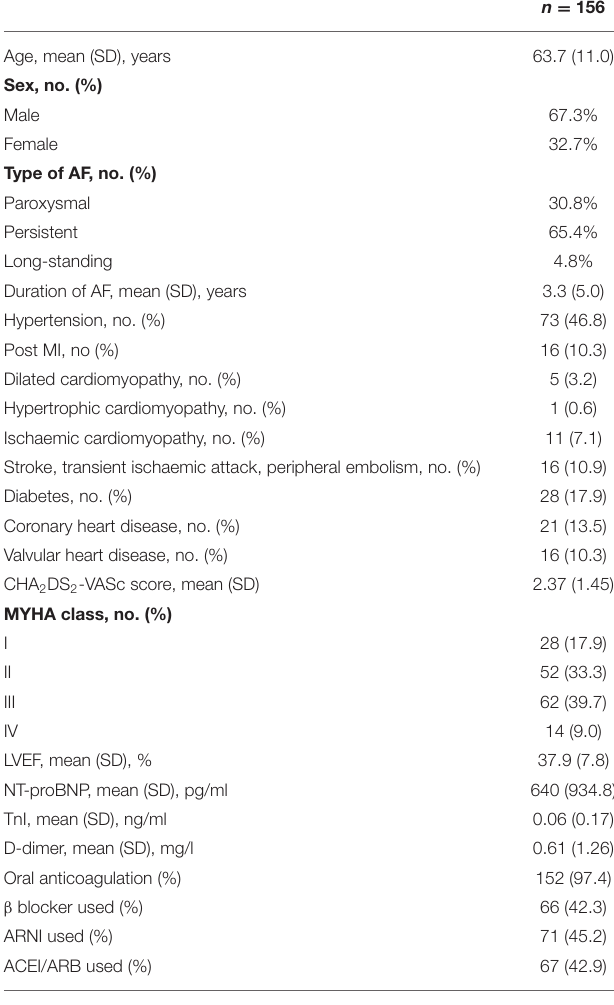
TABLE 1 | Characteristics of patients at